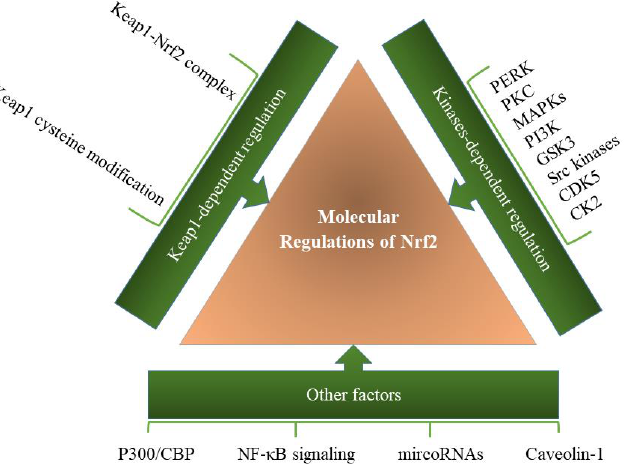
Figure 3. Molecular regulation of the Keap1-Nrf2 pathway. A variety of factors and pathways are involved in regulating the function of the Keap1-Nrf2 pathway, which can be modulated through various factors in the cell.